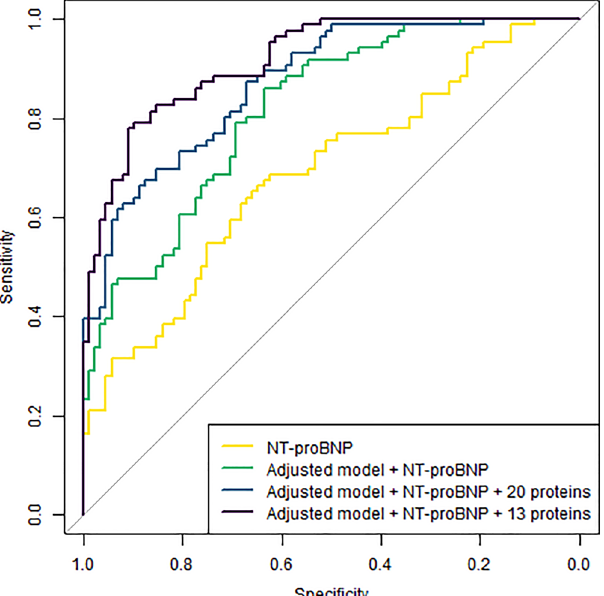
Figure 3. Receiver Operator Characteristic Curve for discrimination of HFpEF in CATHGEN. Shown are four Receiver Operator Characteristic (ROC) curves for discrimination of HFpEF with NT-proBNP alone, the addition of the clinical adjusted clinical model (age, race, body mass index (BMI), systolic blood pressure (SBP), type 2 diabetes mellitus (DM) and creatinine) and the addition of both the 20 validating protein model and the LASSO with Monte Carlo cross-validation 13-protein biomarker model. The 20 validating proteins are: LCN2, U-PAR, IL-1ra, KIM1, CSTB, Gal-9, TIMP-1, MATN2, XCL1, NEMO, CRELD2, MMP7, SUMF2, TXNDC5, PRELP, TMSB10, CDH2, PARP-1, SPINT2, FCGR3B. The 13 LASSO selected proteins were AOC3, CA5A, CA6, CCL16, CLSTN2 , Gal-9, IGFBP3, KIM1, NEMO, PSGL-1, SERPINA12, SUMF2, VEGFD. The addition of either the 20 or 13-protein model to the adjusted model and NT-proBNP improved the discriminative capabilities of the